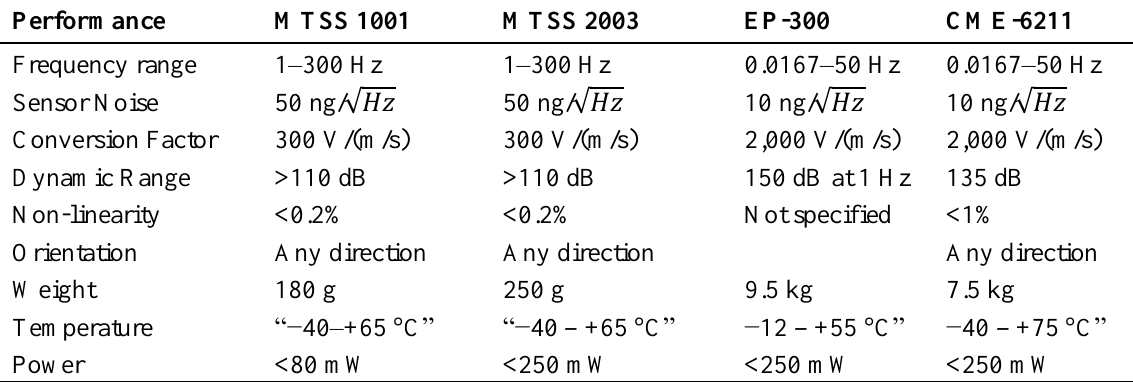
Table 1. Current performance parameters for linear MET seismic